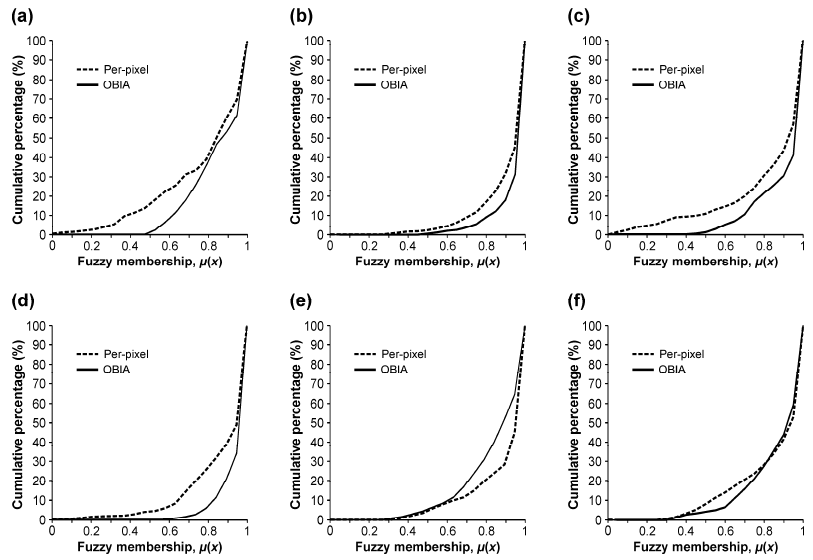
Figure 10. Comparison of fuzzy membership scores assigned contact pixels delineated using equivalent OBIA and per-pixel classifications: ( a ) Li; ( b ) ATM 9; ( c ) ATM PC; ( d ) ATM MNF; ( e ) ATM-Li; and ( f ) ATM-Li MNF.